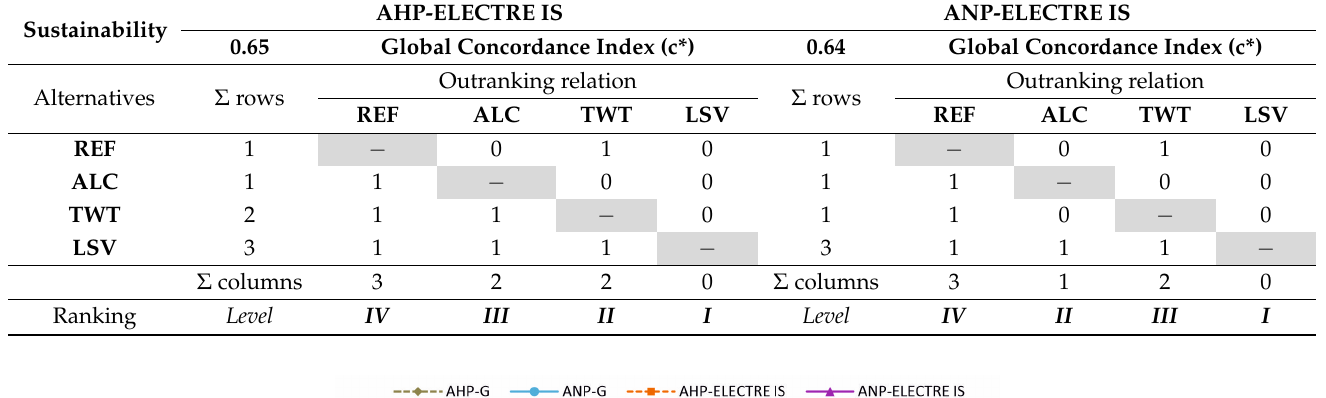
Table 12. Results of sustainability assessment according to AHP and ANP combined with ELECTRE IS.